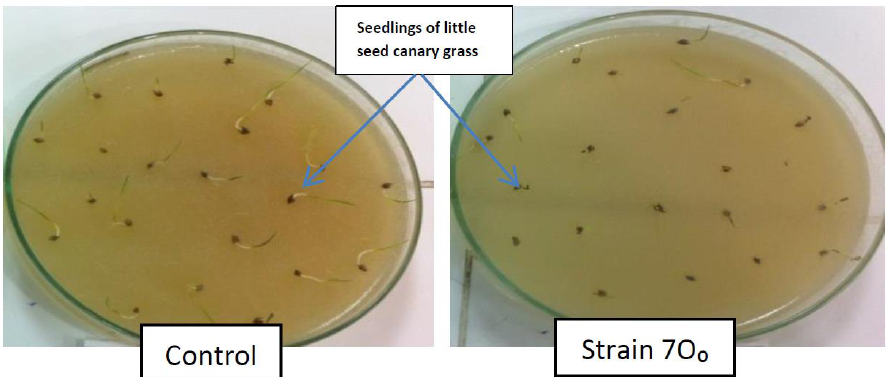
Figure 4. The pictorial view of seedlings of little seed canary grass growing on water agar in agar bioassay.